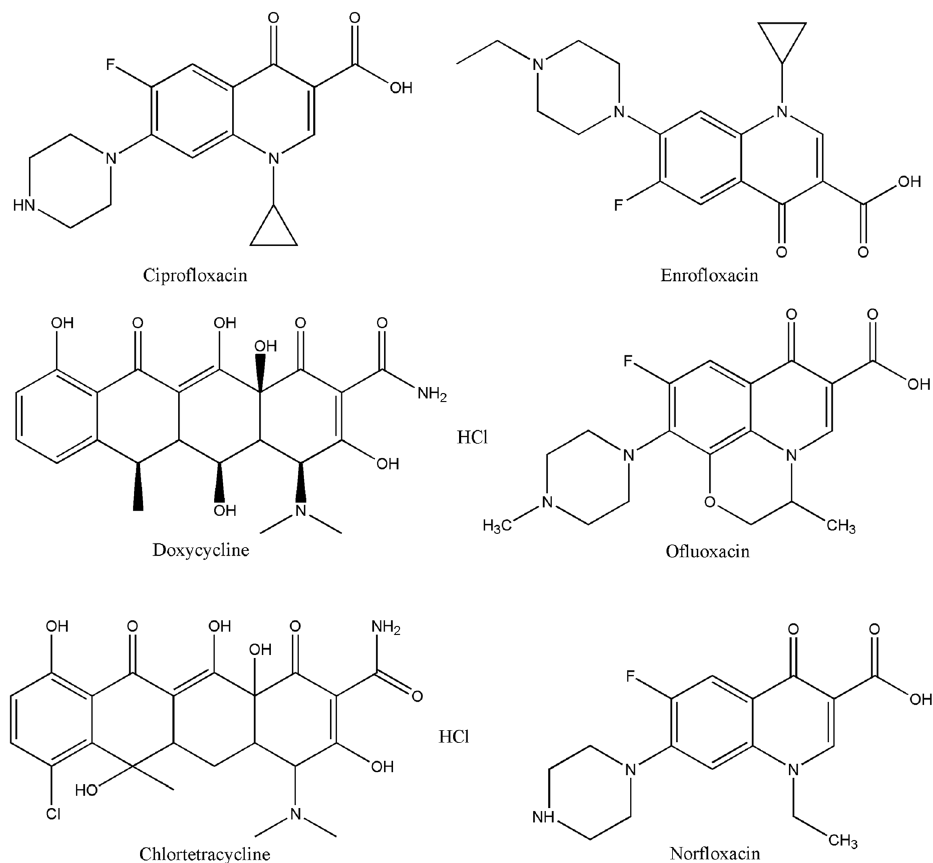
Figure 1. Chemical structures for each DKA compound.